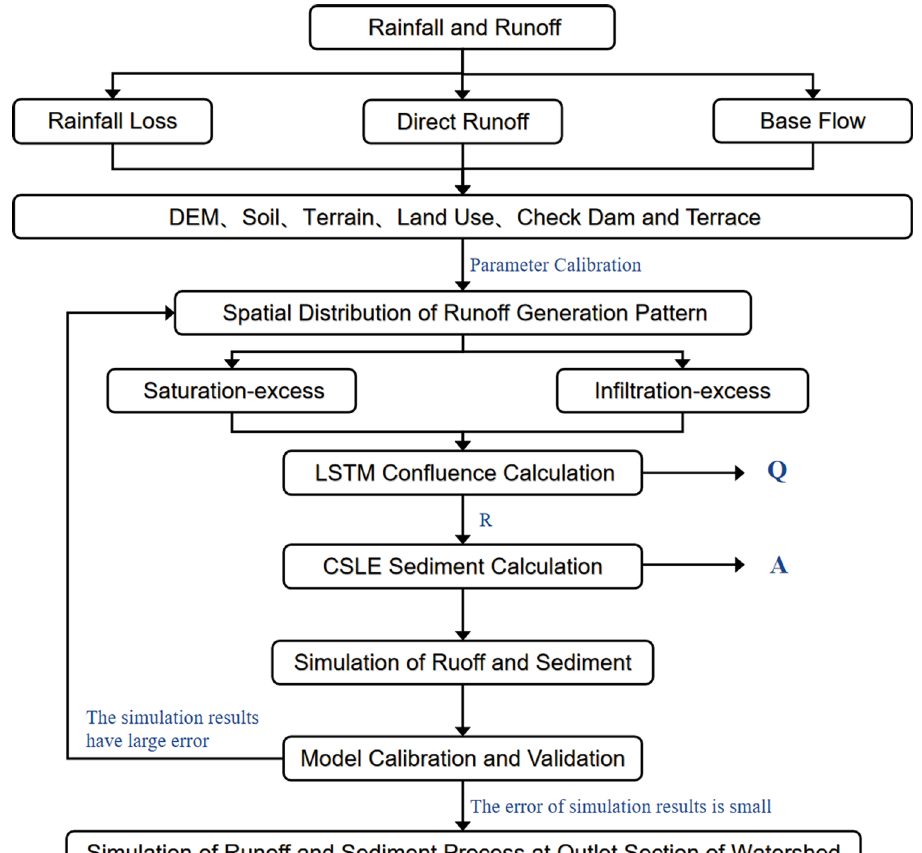
Fig. 1 Ideas of model construc-